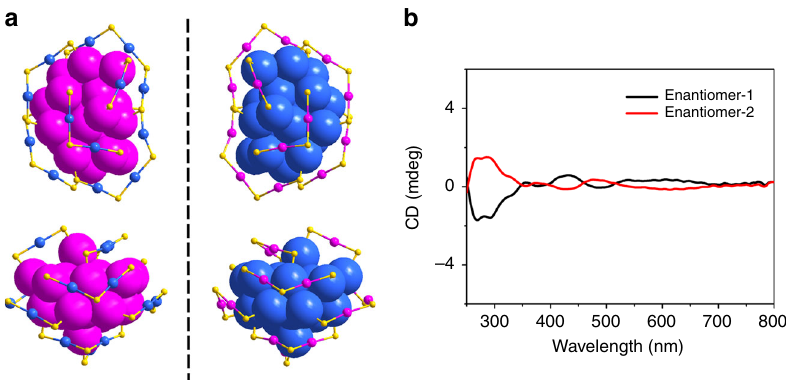
Fig. 5 Chirality of the Au 36 (DMBT) 24 -2D nanocluster. a The enantiomers of Au 36 (DMBT) 24 -2D from top view (upper panel) and side view (lower panel). Color labels: yellow = S, blue/magenta = Au. The C and H atoms are omitted for clarity. b CD spectra of the separated enantiomers of Au 36 (DMBT) 24